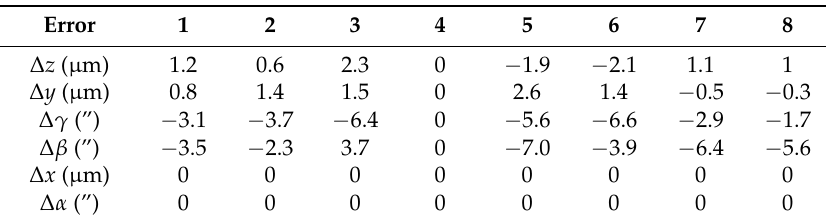
Table 1. Errors of the sub-apertures.